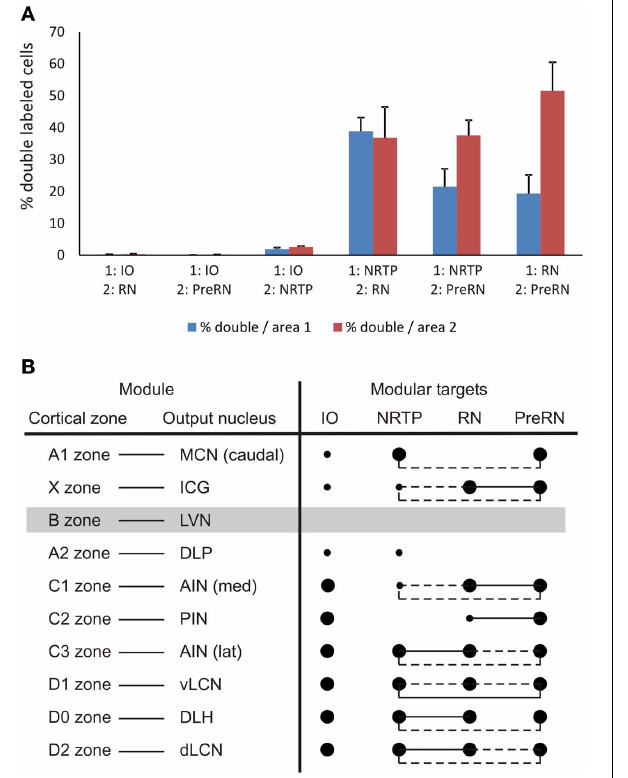
FIGURE 9 | (A) Diagram depicting the average percentage ( + SEM) of double-labeled neurons found in overlapping areas for all six combinations, based on the data of Table 1 . Blue bars refer to the percentage of double labeled cells that project to the first mentioned area of the injection combination but containing both labels. Red bars refer to the percentage of double-labeled cells that project to the other injection site. (B) Overview of projection and collateralization patterns from different parts of the CN to the four investigated brainstem areas and related to the modular organization of the rat cerebellum. Filled large and small circles indicate major and minor projections, respectively, as noted between the listed CN areas and the investigated brainstem areas. Circles linked by pulled or hatched lines indicate that many or some double-labeled neurons, respectively, were encountered in the part of the CN of the same row. The lateral vestibular nucleus (LVN), output nucleus of the B zone, was not specifically studied in the present study (gray